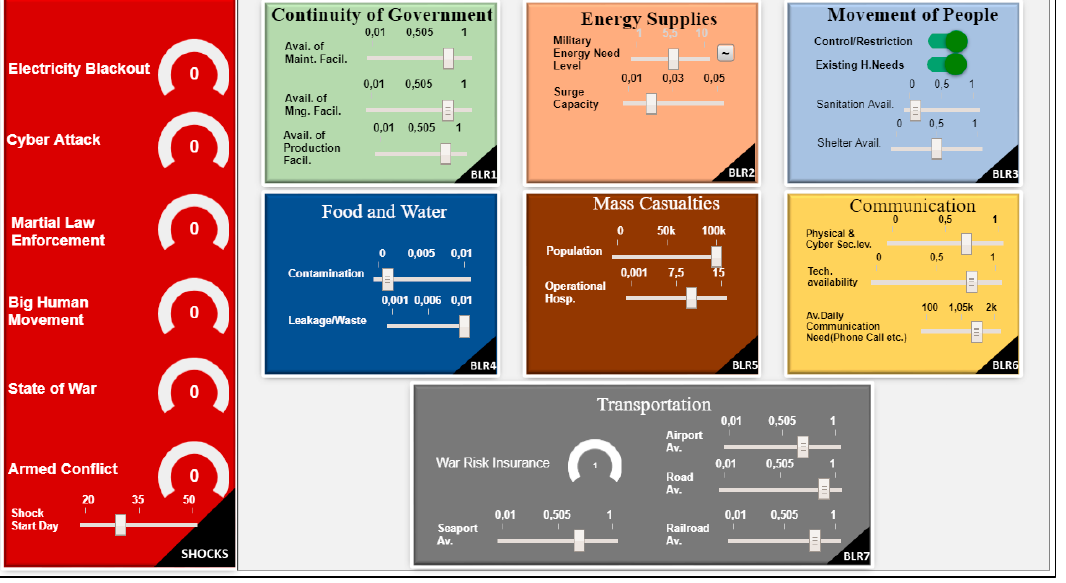
Figure 5. Input dashboard outlook.